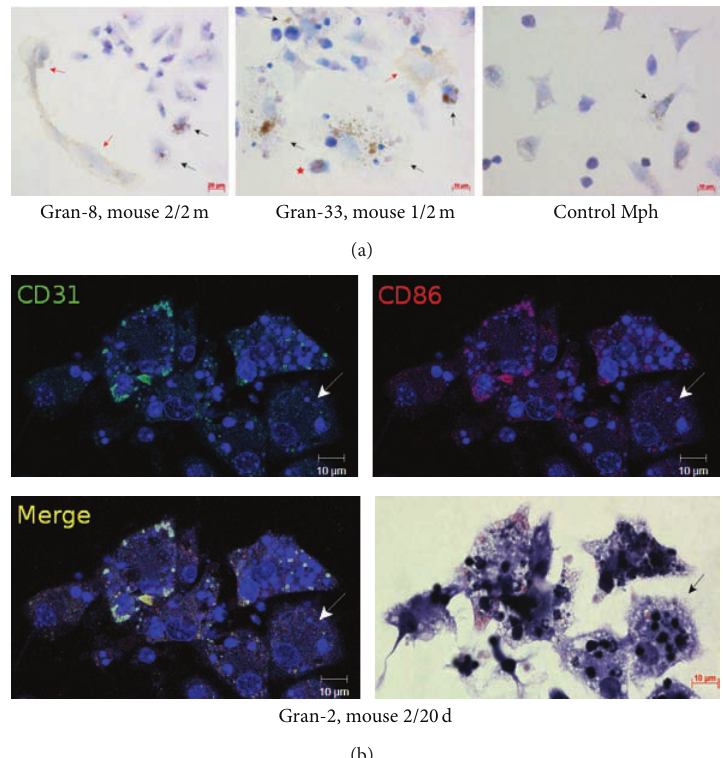
Figure 9: The cell-to-cell adhesive molecule CD31 on the cells in the fragments of mouse splenic granulomas. The scale bars are (a, left panel) 20 𝜇 m and ((a, other panels)-(b)) 10 𝜇 m each. (a) Immunochemical localization of CD31 on granuloma cells and control mouse peritoneal macrophages (Mph). The brown color indicates the presence of the receptor in these cells. The black arrows, red arrows, and red stars indicate macrophages, fibroblasts, and dendritic cells, respectively, stained for this marker. (b) Confocal immunofluorescent localization of the cell- surface receptor CD31 (green signal) and the costimulatory molecule CD86 (red signal) on granuloma macrophages. Colocalization of the markers on confocal images of cells (yellow signal). Nuclei are stained by DAPI (blue signal). In the lower-right panel, the same fragment as in the other panels restained for acid-fast BCG-mycobacteria by the ZN method. A CD31-producing macrophage with BCG-mycobacteria reproducing in it is indicated by the white arrows on the fluorescent images and by the black arrow on the ZN image. Abbreviations as in Figure